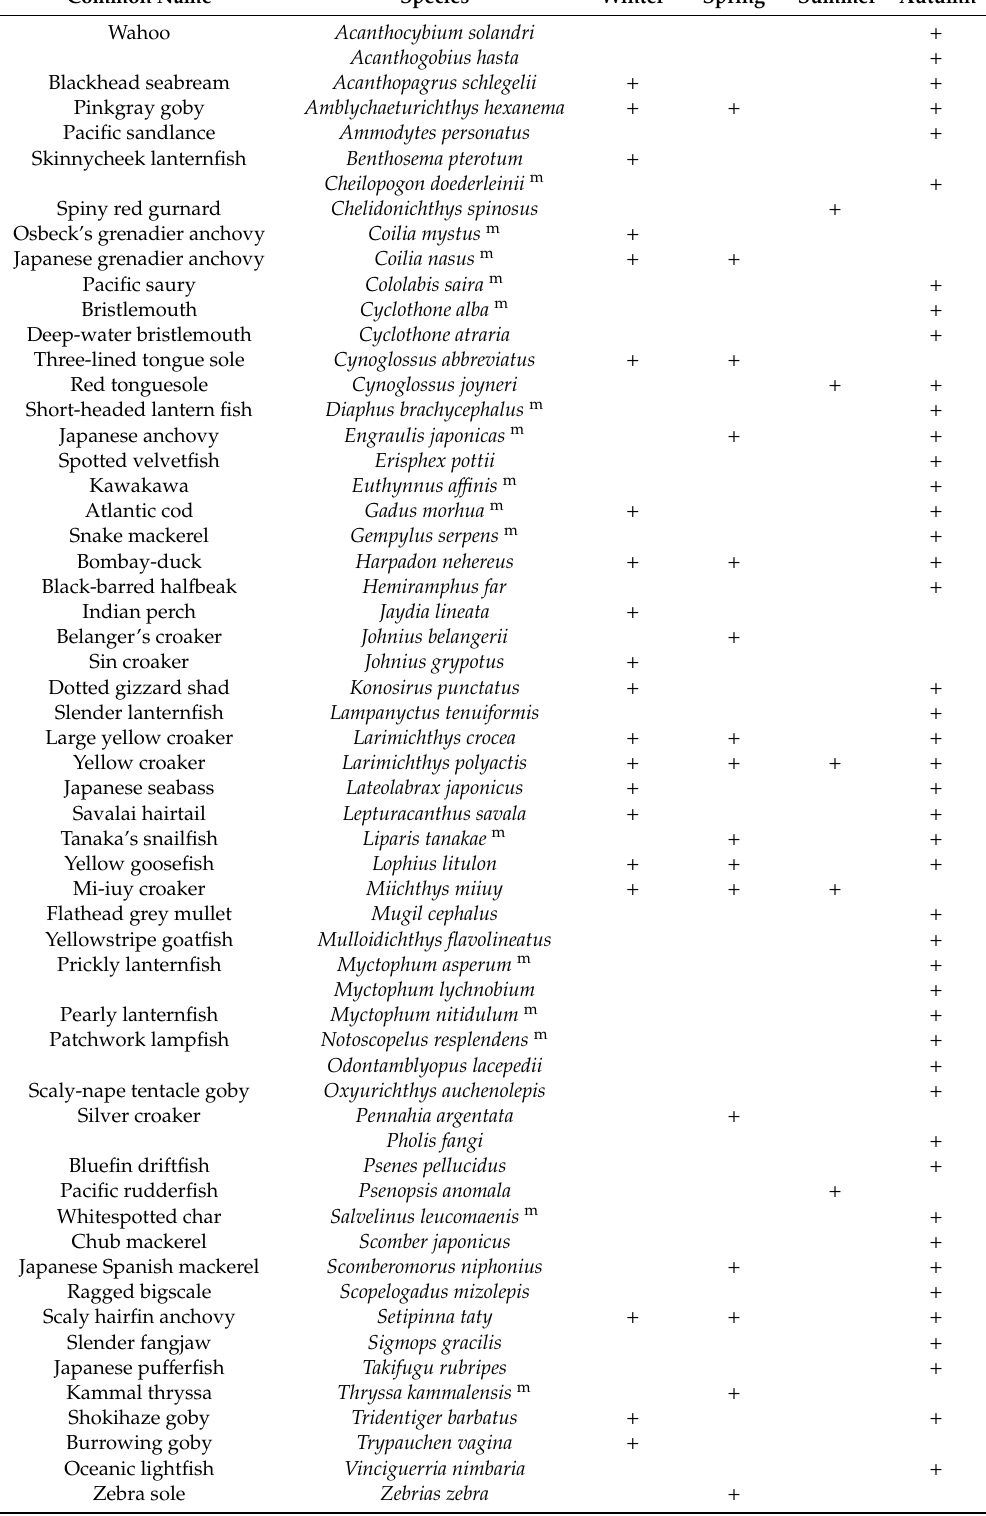
Table 2. Species information in four seasons (“ + ” represents detected species; “ m ” represents migratory